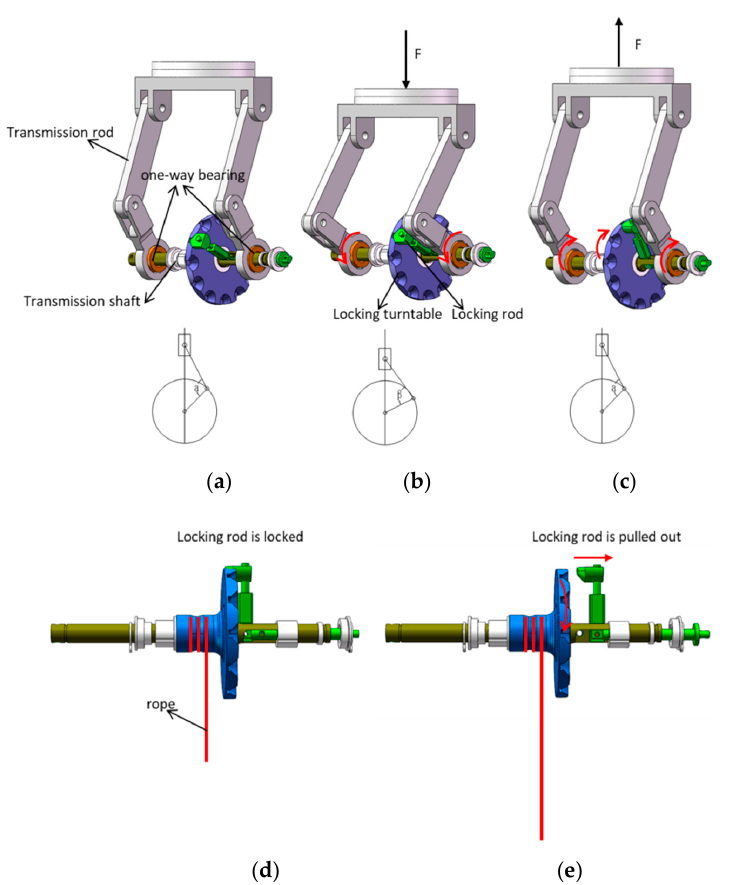
Figure 6. ( a - c ) The process of energy storage in which the transmission rods convert the DEA vertical motion into a one-way rotation of the transmission shaft. When the DEA moves downward, the transmission rods rotate anticlockwise around the transmission shaft. The transmission shaft does not rotate because the one-way bearings are neutral. When the DEA moves upward, the transmission rods rotate clockwise around the rotating shaft, leading to same directional rotation of the rotating shaft, thus accomplishing winding of the rope. (d&e) The process of energy release. After the rope is wound a certain number of turns, the locking rod on the locking turntable is pulled out; the locking turntable is thereby separated from the transmission shaft, and the rope is retracted to release